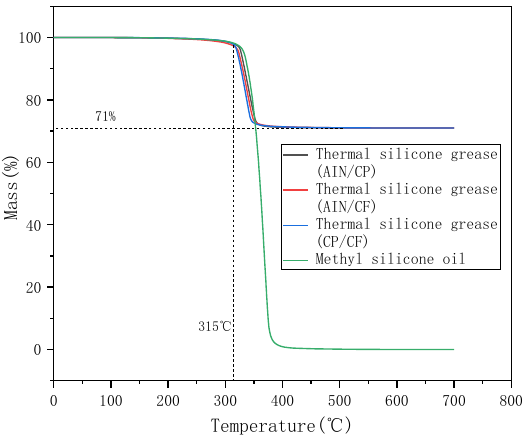
Figure 9. TGA curve of TSGs and silicone oil.